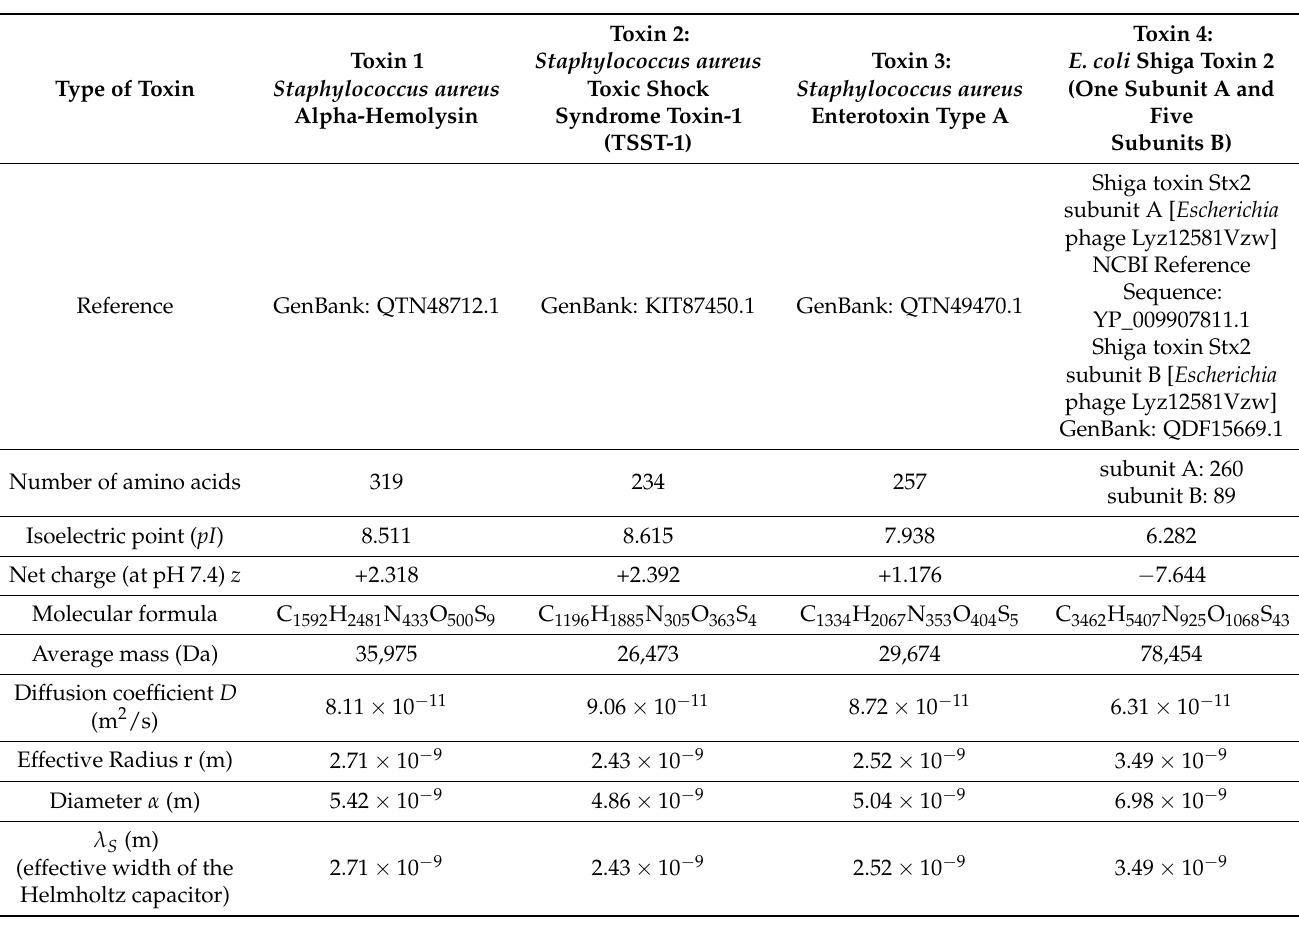
Table 1. Characteristics of examined